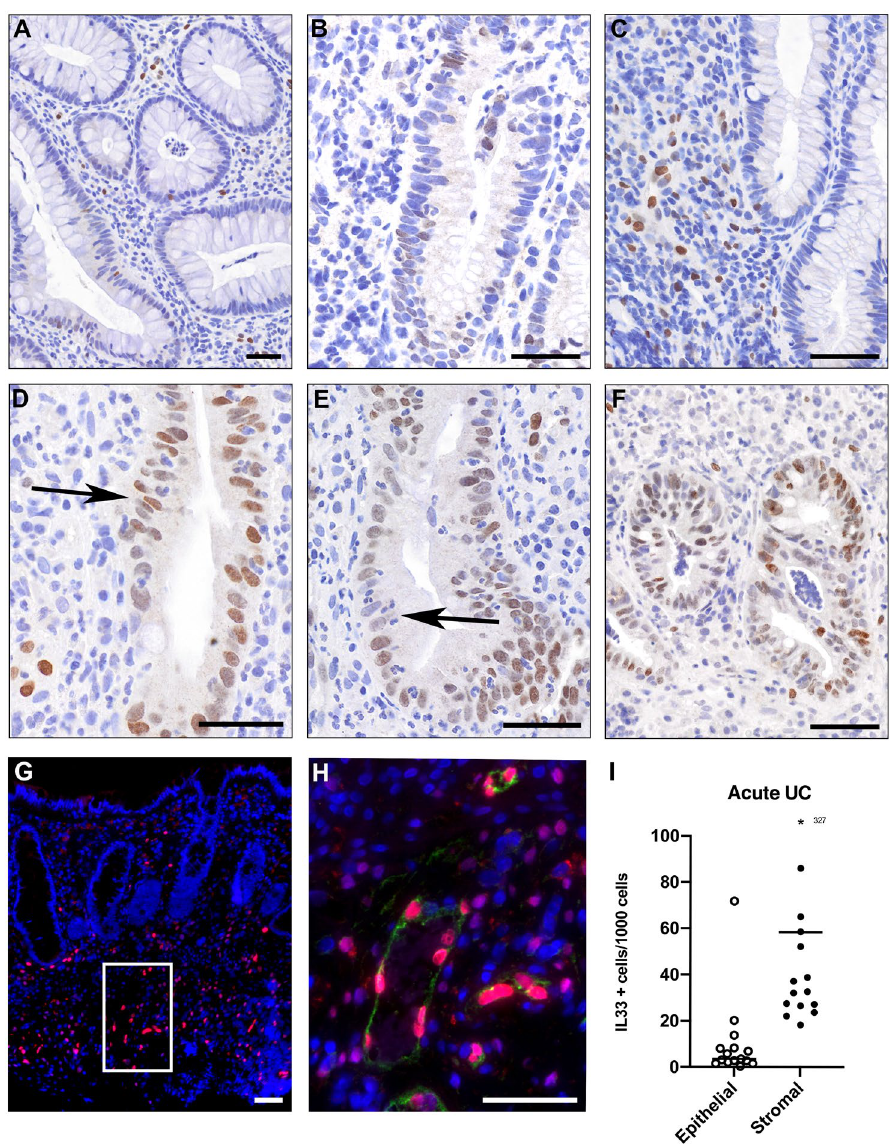
Figure 1. IL-33 in acute ulcerative colitis (AUC) . Image ( A-F) show formalin-fixed, paraffin-embedded colonic biopsies stained for IL-33 (brown) and nuclei stained with hematoxylin (blue). Arrows point to inflammatory cells infiltrating the epithelium. Scales bars = 50 μm. Image ( G) shows dual staining of AUC with IL-33 (red) and endothelial vessels marked by CD34 (green). White frame in image ( G) is enlarged as image ( H). Scale bars = 50 μm. The graph to the far right ( I ) shows positive IL-33 cells per 1000 cells quantified by Qupath analysis software into epithelial and stromal compartments. Asterisk: 327 positive cells/1000